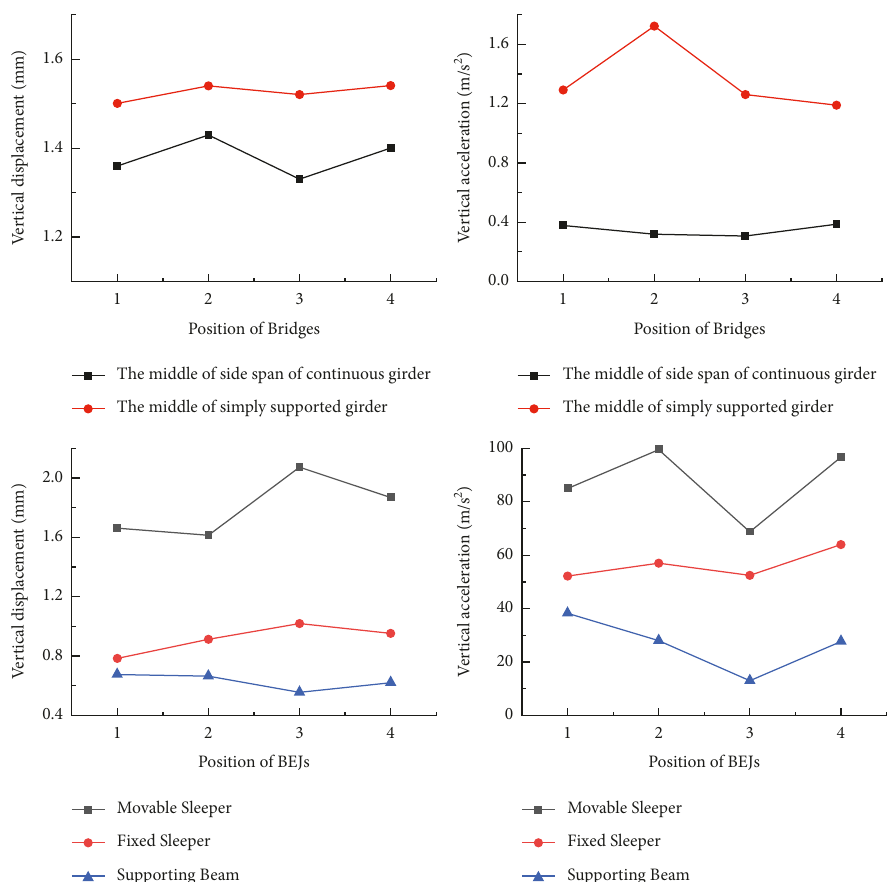
Figure 9: The maximum value of vertical dynamic response of BEJs and bridges at different positions in Case 1.